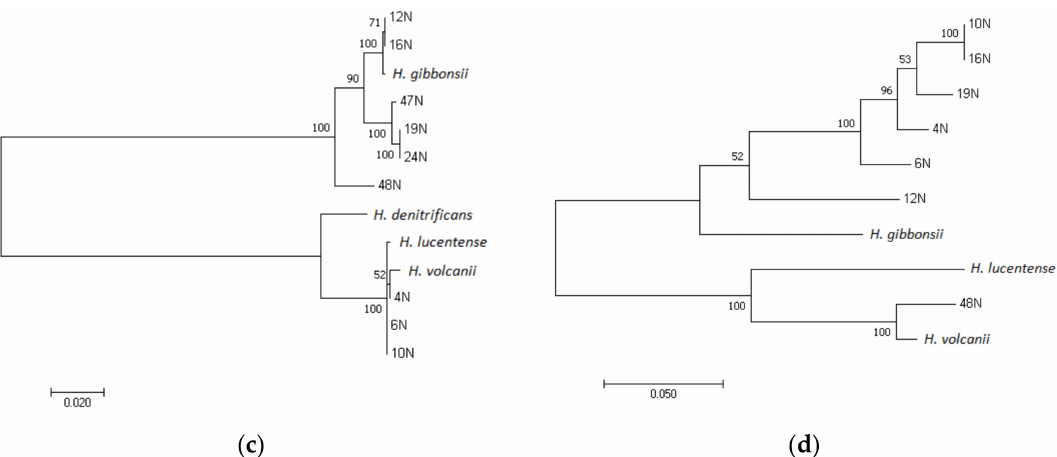
Figure 4. Molecular phylogenetic analysis by Maximum Likelihood method of genes related to glycosylation. The evolutionary history of trees ( a , b , d ) were inferred by using the Maximum Likelihood method based on the Tamura-Nei model [31]. The percentage of trees in which the associated taxa clustered together is shown next to the branches. The unrooted trees are drawn to scale, with branch lengths measured in the number of substitutions per site. Evolutionary analyses were conducted in MEGA7